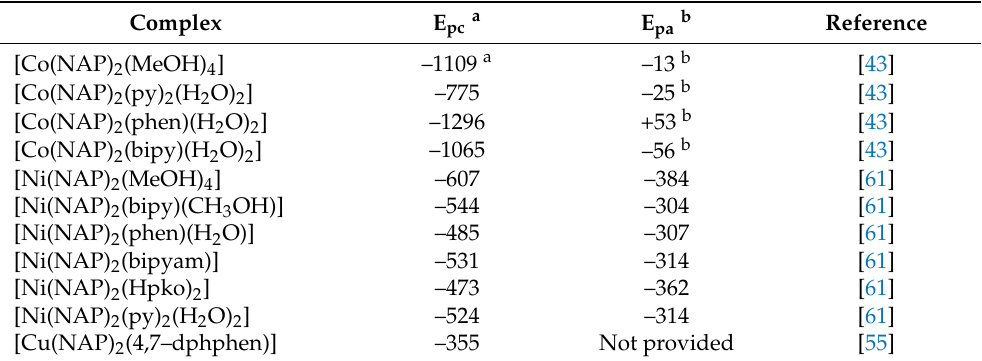
Table 9. Cathodic and anodic potentials (in mV) for the redox couples [M(II)]/[M(I)] (M = Co, Ni and Cu) (E pc1 , E pa1 ) for complexes bearing naproxen